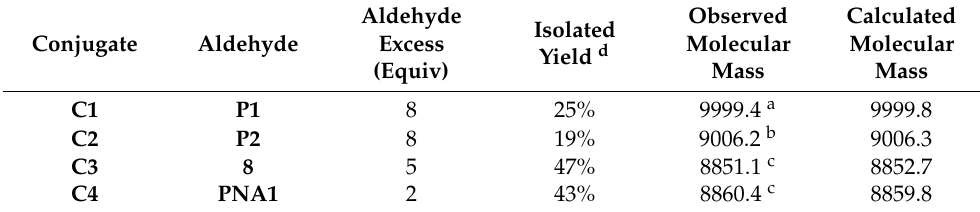
Observed molecular masses were calculated from the most intensive isotope at a [(M–10H)/10)] 10 , b [(M–6H)/6] 6 − , and c [(M-4H)/4] 4 − . d Yields were determined from the UV absorbance at 260 nm using the molar absorptivity of the corresponding